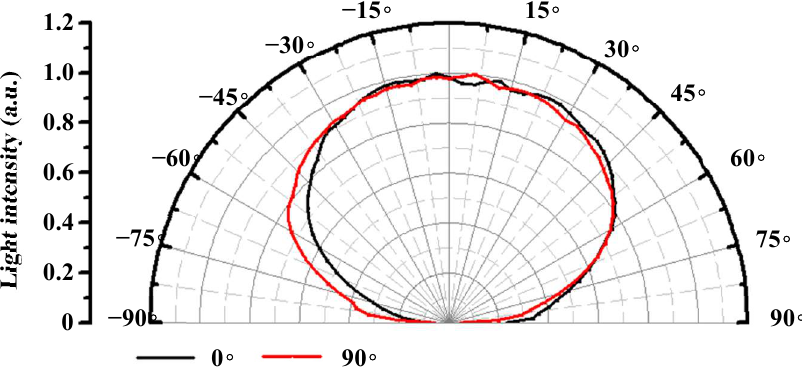
Figure 4. Mini-LED chip light distribution curves. The QC100B QD film (UBright Optronics Corporation, Taoyuan City, Taiwan) was used (its structure is illustrated in Figure 5). The QD’s film thickness was 100 μm, and its applicable excitation wavelength was between 448 nm and 455 nm; the peak wavelength and FWHM of the spectrum for the green QD were 534 nm and 23 nm, respectively; the peak wavelength and FWHM of the spectrum for the red QD were 629 nm and 23 nm, respectively. According to the EL spectrum in the CIE 1931 color gamut coordinates, the part-to-part white point variation of the film was ≤0.01 for both x and y.